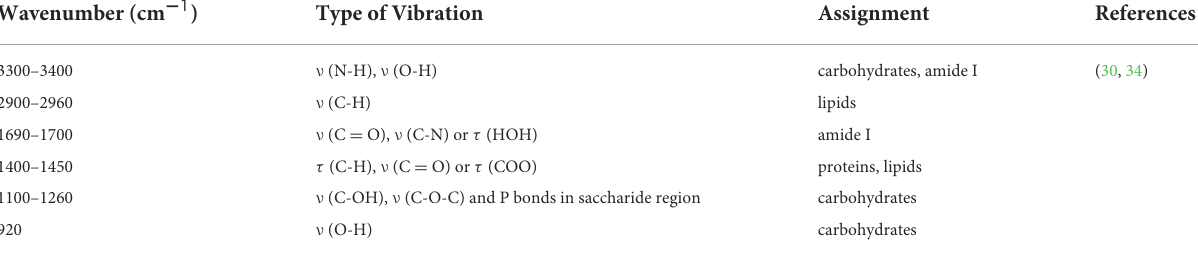
TABLE 2 Assignment of the main bands of FT-IR spectra.